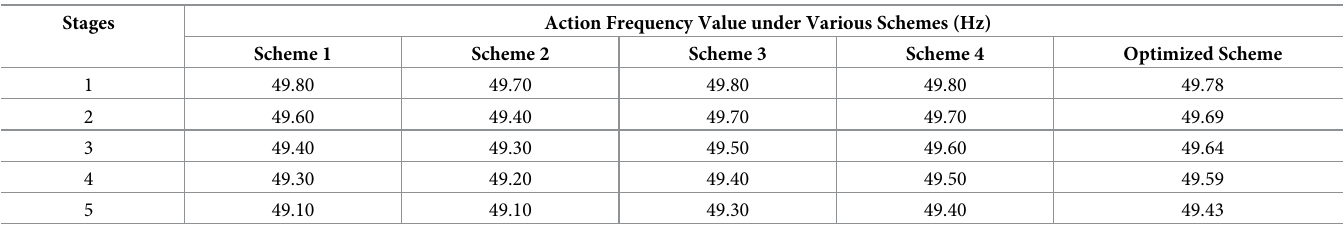
Table 14. Comparison of five schemes (Case 2).